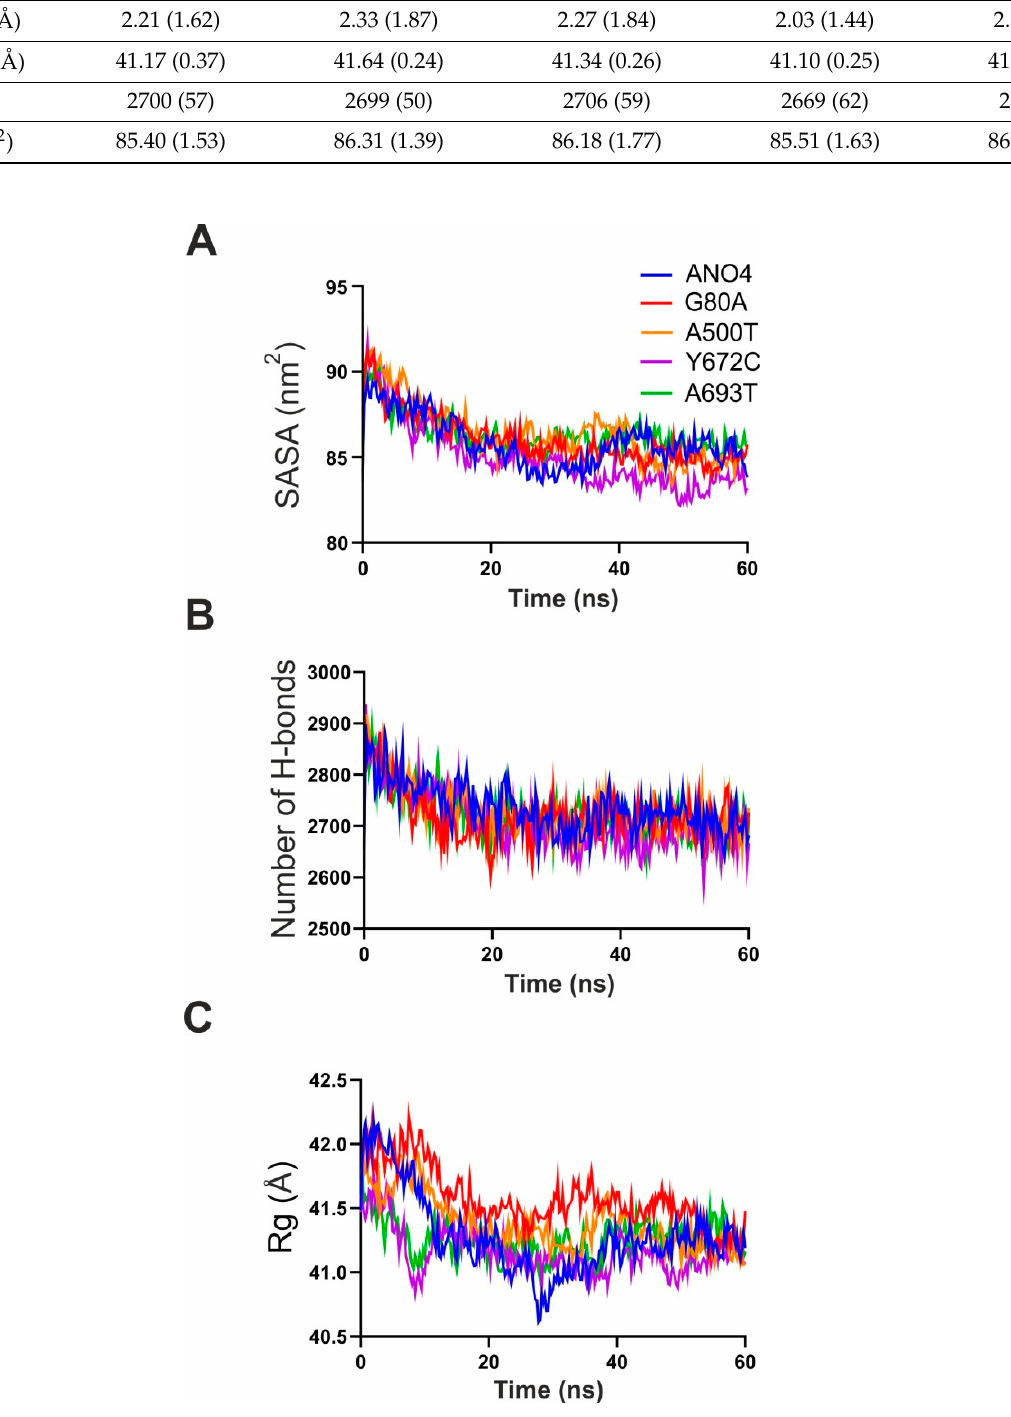
Figure 5. Stability of the ANO4 WT and mutant structures during MDS was assessed by means of ( A ) solvent accessible surface area, SASA, ( B ) number of H-bonds, and ( C ), radius of gyration, Rg.